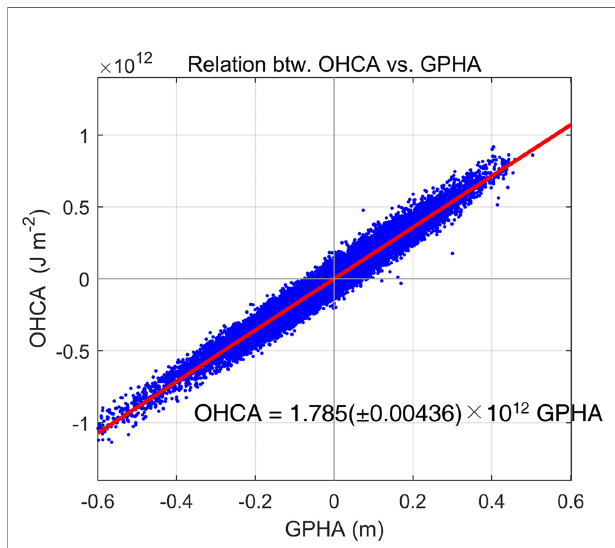
FIGURE 2 | Scatterplots for geopotential height anomaly (GPHA) and ocean heat content anomaly (OHCA) calculated with historical hydrocasts (EN4 version 4.2.1, Good et al., 2013). The red line is a linear regression with the slope of 1.785×10 12 and the value in parenthesis is the 95% con fi dence interval. The relationship was used to convert GPHA to OHCA.